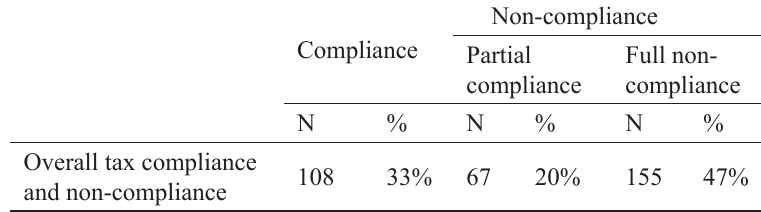
Results of Overall Tax Compliance and